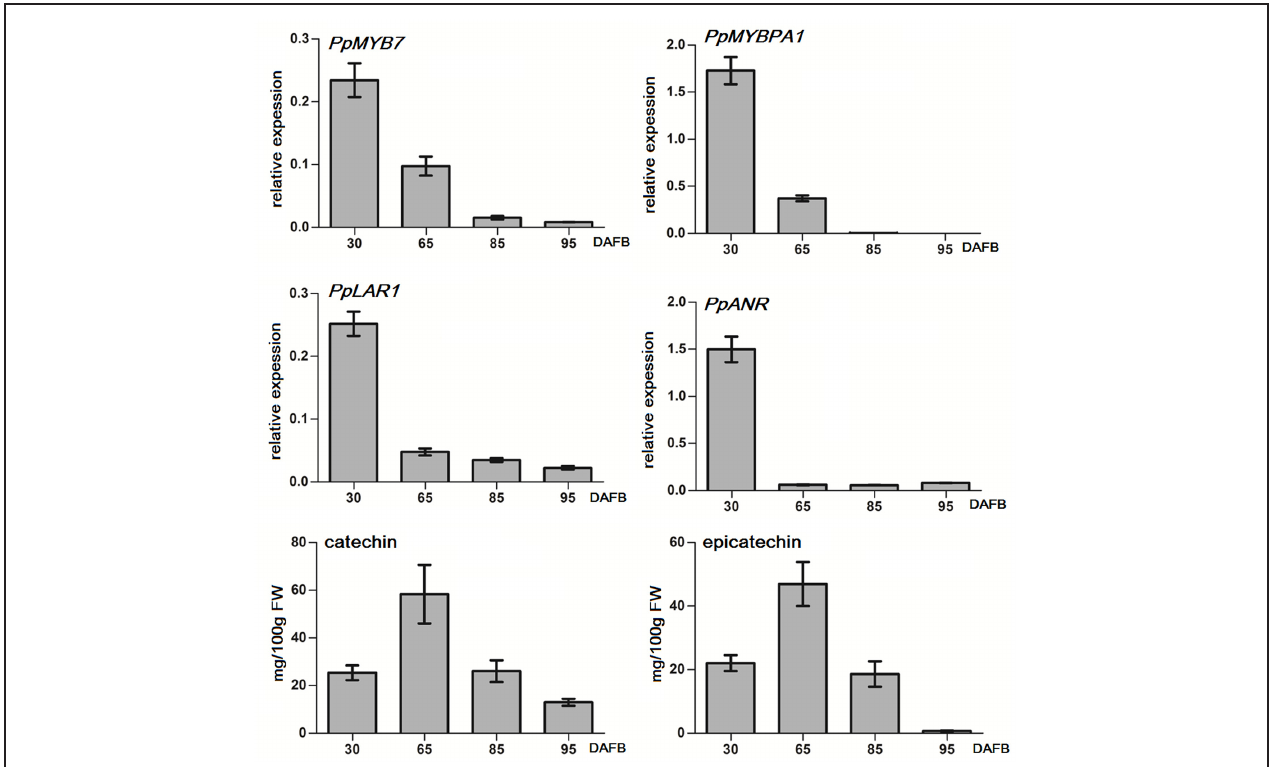
FIGURE 4 | Quantitative real-time PCR (qRT-PCR) analysis of the expression profiles of genes related to PA synthesis and flavan-3-ol content in fruits of peach cv. Baifeng that were at different stages of development in 2012. qRT-PCR was done for three technical replicates. Catechin and epicatechin contents represent the means of three biological repeats. Error bars show SE of the mean. DAFB stands for days after full bloom. A biological replicate was conducted for fruit samples collected in 2013, and the results (Supplementary Figure S2) are similar to those in